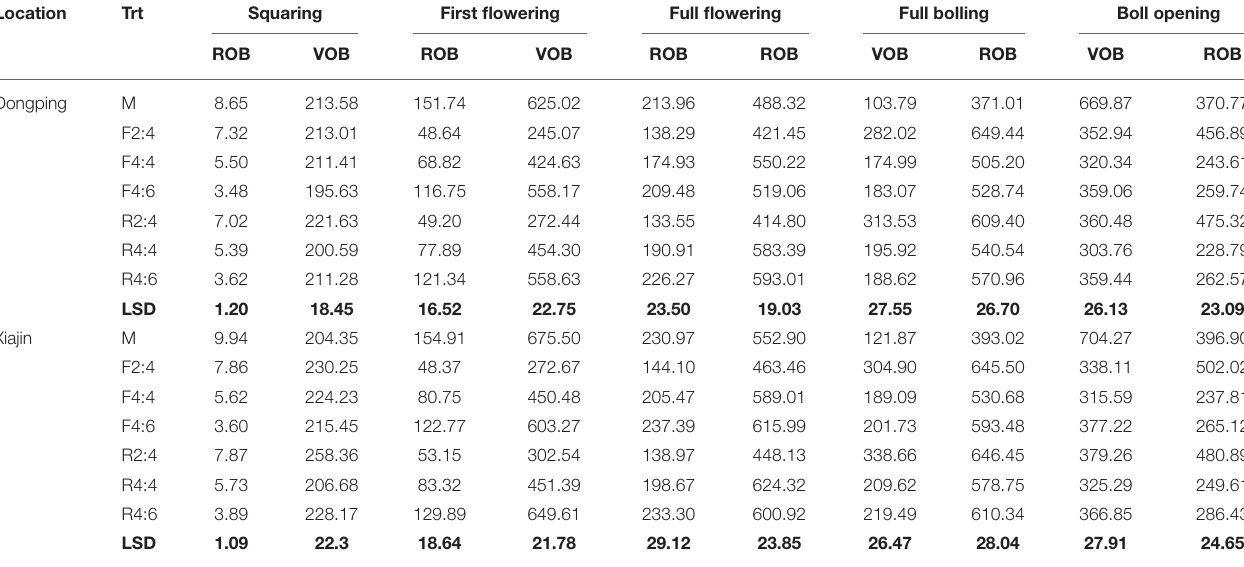
TABLE 4 | Cotton reproductive organs biomass (ROB) and vegetative organs biomass (VOB) accumulation in